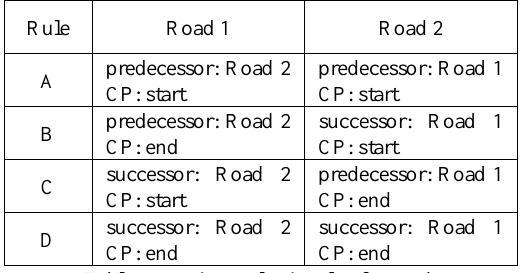
Table 1. Basic topologic rules for